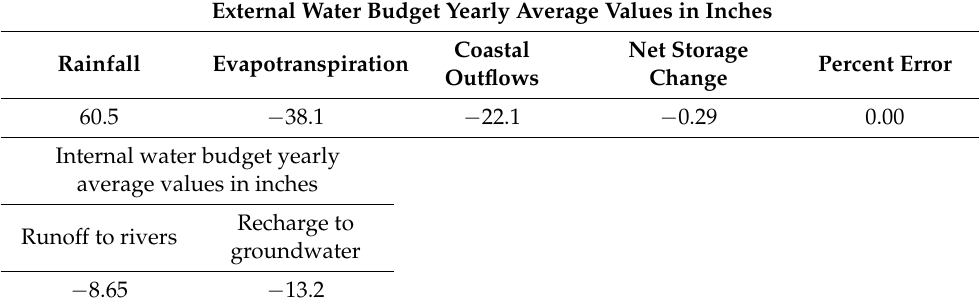
Table 7. External and internal water budget for entire simulation period; positive values indicate flux into the model watersheds.